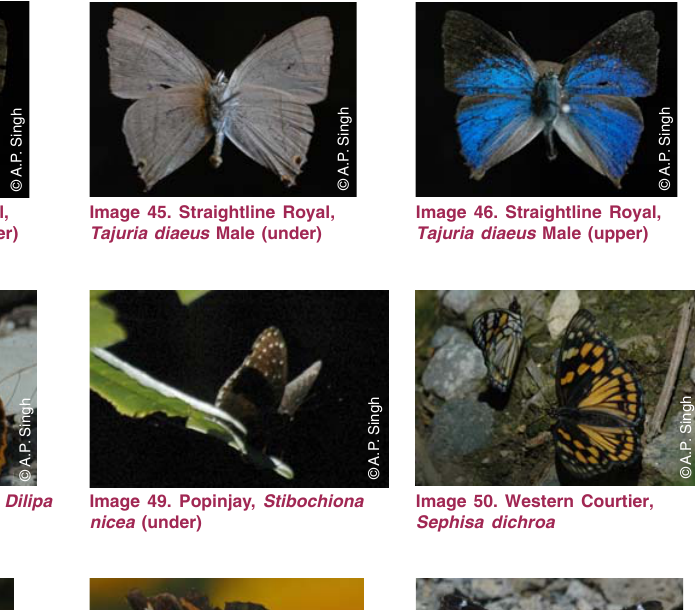
Image 50. Western Courtier, Sephisa dichroa